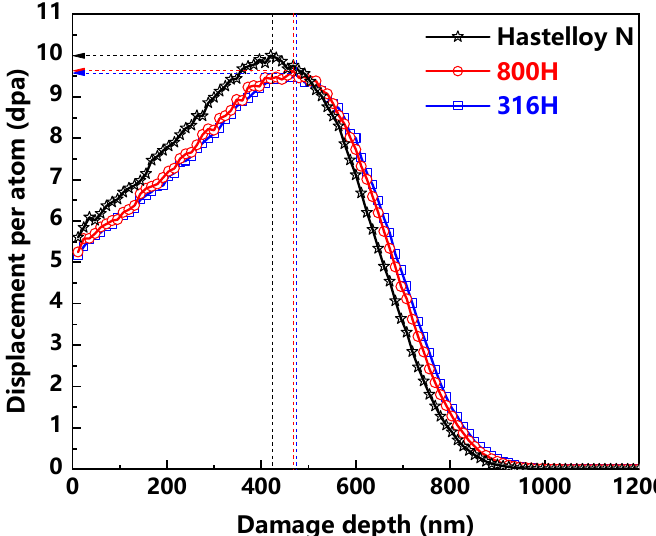
Figure 1. SRIM calculation of the damage profiles produced by 4MeV Xe 20 + with the ion dose of 3.37 × 10 15 ion / cm 2 in the Hastelloy N alloy, Alloy 800H and 316H stainless steel.